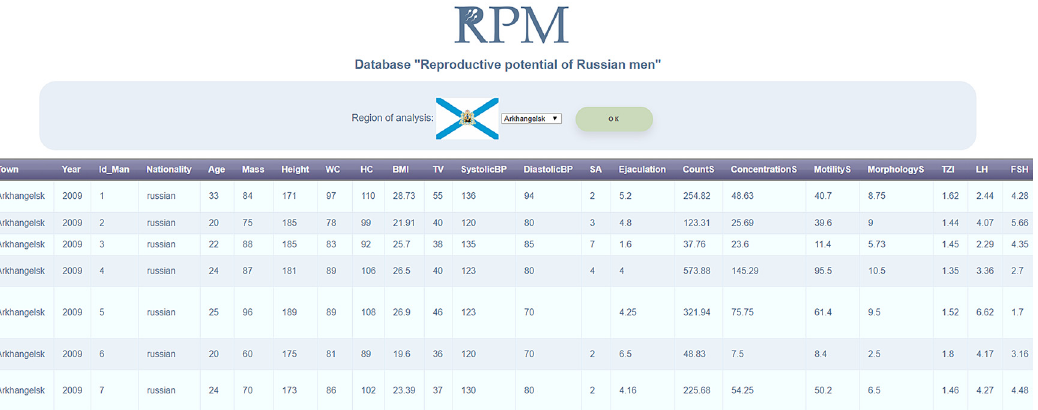
Figure 4: Example of the web-interface to the database «Reproductive potential of the male population of Russia». The visual- ization screen shows example of data from the Arkhangelsk